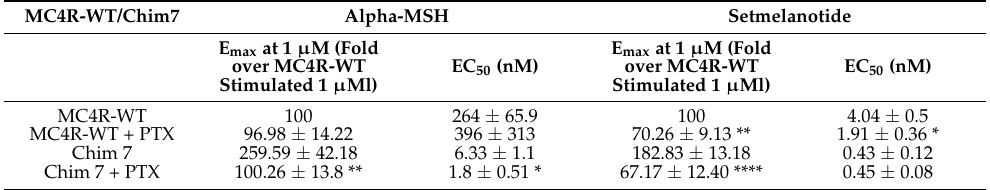
Figure 5. NFAT reporter gene assay investigating signaling profile of PTX pretreated MC4R-WT-WT and Chim 7. Calcium mobilization was measured using NFAT reporter gene assay. HEK293 cells were pretreated with PTX or not, assessing possible increase in Ca 2+ due to G i signaling effects. Data are given in percentage of MC4R-WT-WT signaling. Cells were stimulated with ( A ) alpha-MSH (fold over MC4R-WT at 1 µ M was set as 100%) or with ( B ) setmelanotide (fold over MC4R-WT at 1 µ M was set as 100%). E max and EC 50 values are summarized in Table 2. Data represent two to nine independent experiments, each performed in triplicate. Values represent mean ± SEM. Table 2. Potency (EC 50 ) of ligand stimulated MC4R-WT and Chim 7 including PTX pretreatment. Concentration-response curves were used to determine potency under alpha-MSH and setmelanotide stimulation. Data are given as the result of two to nine independent experiments performed in triplicate. Values represent mean ± SEM. Statistical analysis was performed using the Mann–Whitney test comparing E max of WT or Chim 7 to respective WT + PTX or Chim 7 + PTX. The same testing was performed for statistical EC 50 analysis and comparison. Statistical significance is indicated by * p < 0.05, ** p < 0.01, and **** p <